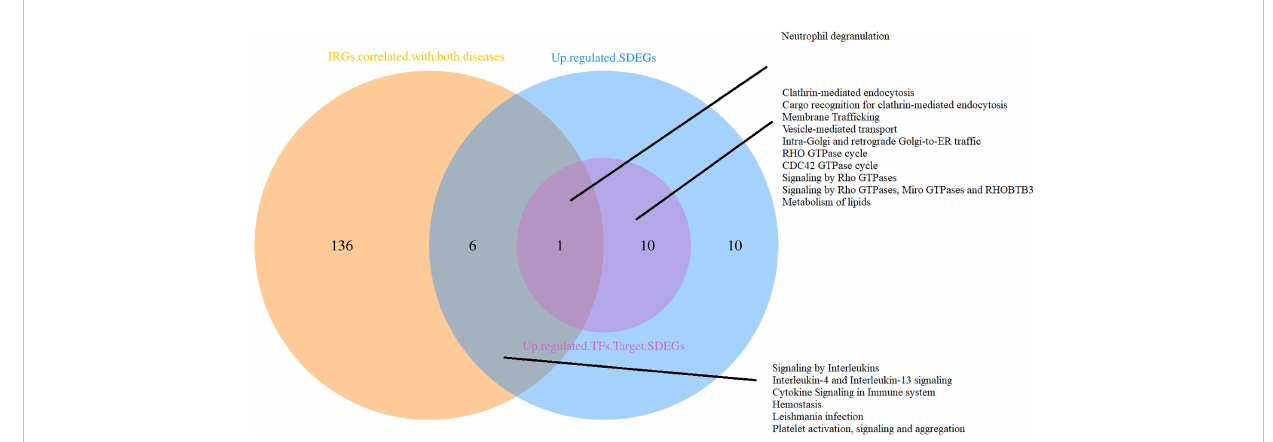
FIGURE 6 Functional analyses of gene sets positively correlated with both pJIA and uveitis.